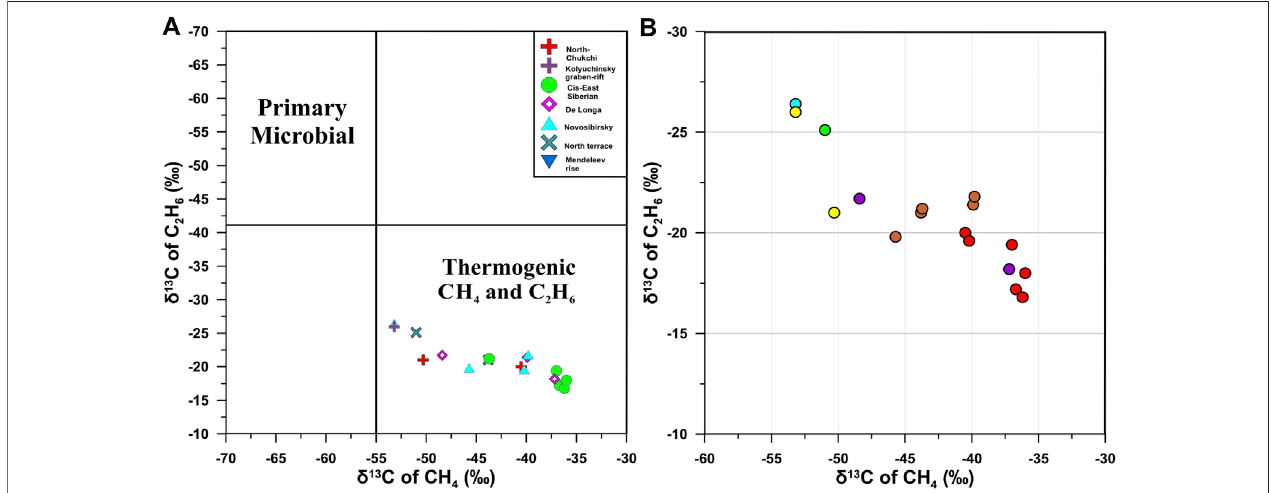
FIGURE 7 | Plot of values of δ 13 C-C 2 H 6 versus δ 13 C-CH 4 after Milkov et al., 2005. Plot of values of δ 13 C-C 2 H 6 versus δ 13 C-CH 4 with author ’ s gas genetic groups (B) . Genetic groups are the same such as in Figure 5 .